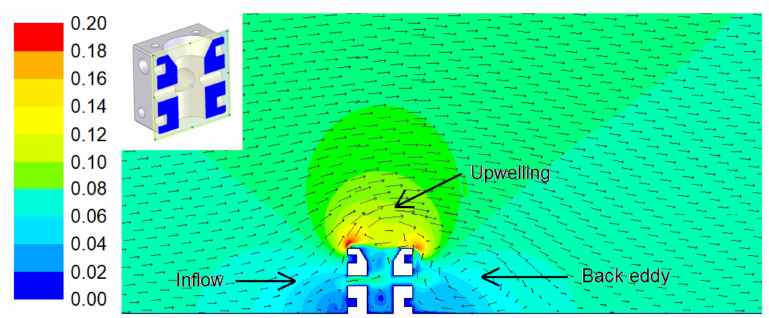
Figure 8. Velocity field (m/s) obtained by the CFD